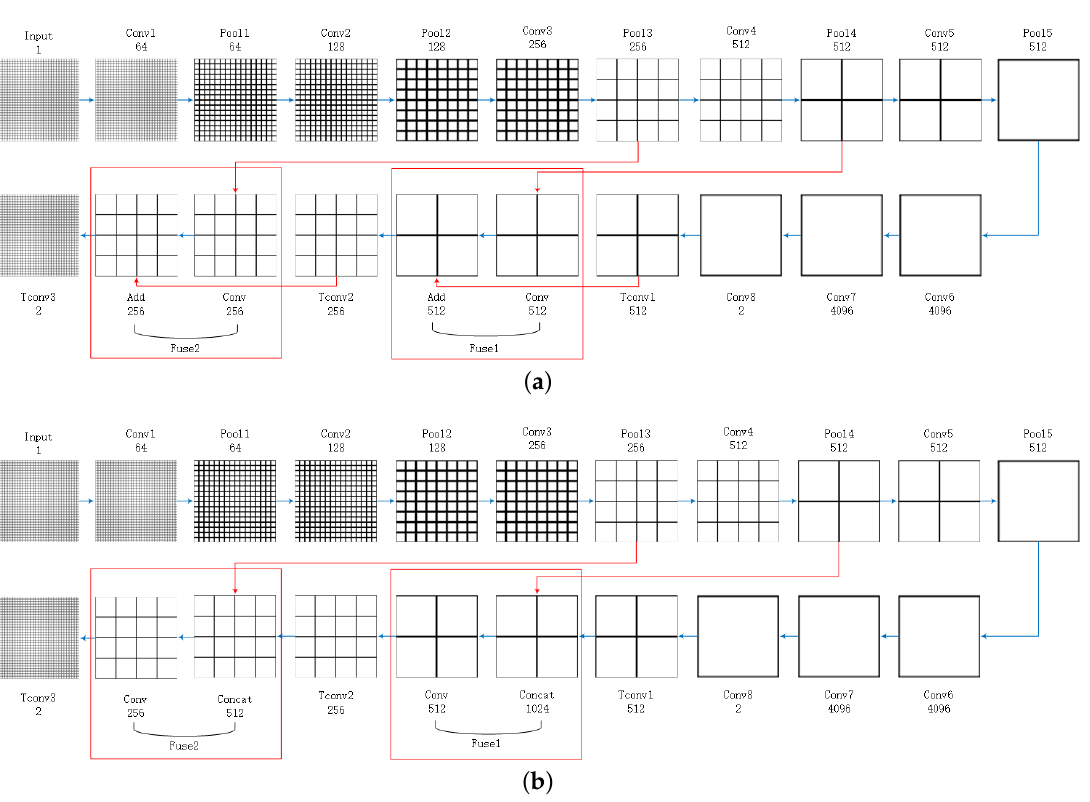
Figure 4. The training processes of the two models: ( a ) FCN; and ( b ) FCN16. The number of grids reveals relative spatial coarseness. Convolution numbers of ConvX are given in Table 2. Both models upsample stride 32 predictions back to pixels in three steps. Tconv1 and Tconv2 achieve double upsampling and Tconv3 achieves eight times upsampling. Different structures between the two models are marked with red. The number under layer name is channel